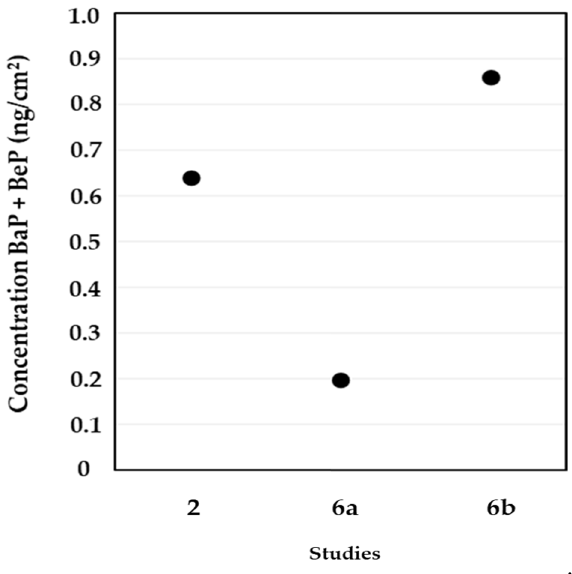
Figure 4. Concentrations of benzo(a)pyrene and benzo(e)pyrene on the skin of firefighters after firefighting activities (2—Fernando et al. [45] (neck, wrist, back, forehead and fingers); 6—Banks et al. [42] (a—diesel pan fire; b—particleboard fire) (neck and wrist)). Other possible/probable carcinogenic PAHs were found on the skin of the firefighters after fire combat. Naphthalene was determined in two studies, at levels varying between 1.11 ng/cm 2 and 25.6 ng/cm 2 on the neck skin of subjects participating in training exercises [43,45]. Levels of benz(a)anthracene were reported in four studies, with values ranging from 0.04 ng/cm 2 , on the collarbone skin of team leaders (firefighters controlling the fire from outside the burn house; Sjöström et al. [29]), to 33.69 ng/cm 2 , on the neck skin of subjects attending a wood pallet fire [43]. Moreover, Andersen et al. [43] highlighted that benz(a)anthracene was the predominant PAH with carcinogenic properties on the skin of firefighters. In the study performed by Banks et al. [42], the skin values of benz(a)anthracene and chrysene are reported collectively: 0.038 ng/cm 2 (at the wrist) and 0.050 ng/cm 2 (at the neck) after a diesel pan fire, and 0.25 ng/cm 2 (at the neck) and 0.51 ng/cm 2 (at the wrist) after a particleboard fire. So far, only four studies have described the levels of chrysene on the skin of exposed firefighters, with concentrations ranging between 0.04 ng/cm 2 on the collarbone skin of team leaders [29] and 3.06 ng/cm 2 on the neck skin of subjects participating in a training fire [43]. Concentrations of benzofluoranthene isomers, benzo(b)fluoranthene, benzo(j)fluoranthene, and benzo(k)fluoranthene have been reported on the skin of firefighting forces [29,42,45]. The highest levels of benzo(b)fluoranthene was found on the skin of fire starters’ wrists (total of 0.41 ng/cm 2 [29]), while 0.03 ng/cm 2 of benzo(j)fluoranthene was the lowest value determined on the skin of the neck, forehead, back, and fingers of firefighters participating in a training exercise with untreated wood as fuel [45]. Recently, Banks et al. [42] also included the analysis of benzo(b)fluoranthene and benzo(k)fluoranthene and observed predominantly increased skin concentrations after particleboard fires (0.33 ng/cm 2 for the neck and 1.00 ng/cm 2 for the wrists) than after a diesel-based fire (0.47 ng/cm 2 on the neck and 0.069 ng/cm 2 on the wrists). Baxter et al. [34] also highlighted the predominance of benzofluoranthene isomers on the skin of the face and neck of North American firefighters after five fire events. Dermal concentrations of indeno(1,2,3-c,d)pyrene varied between 0.04 ng/cm 2 , on the skin of the collarbones of firefighters working at the fire front [29], to 5.15 ng/cm 2 , on the neck of the subjects involved in a fire with wood pallets, mattresses, and electrical cords [43]. Regarding dibenz(a,h)anthracene, only two studies were able to quantify the levels of this compound on the skin of the firefighters. Banks and coworkers